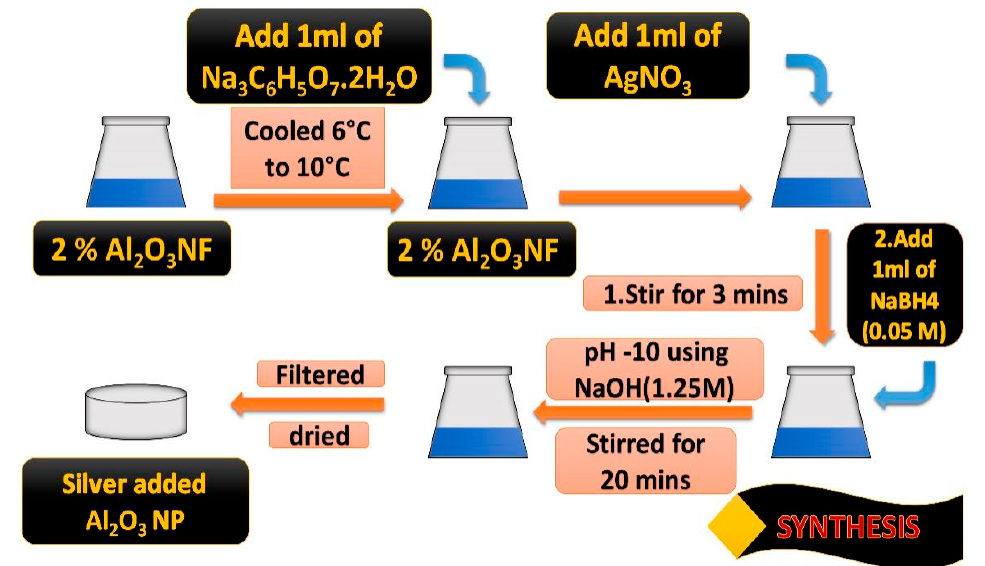
Figure 1. The steps in the preparation of silver-loaded Al 2 O 3 NPs.